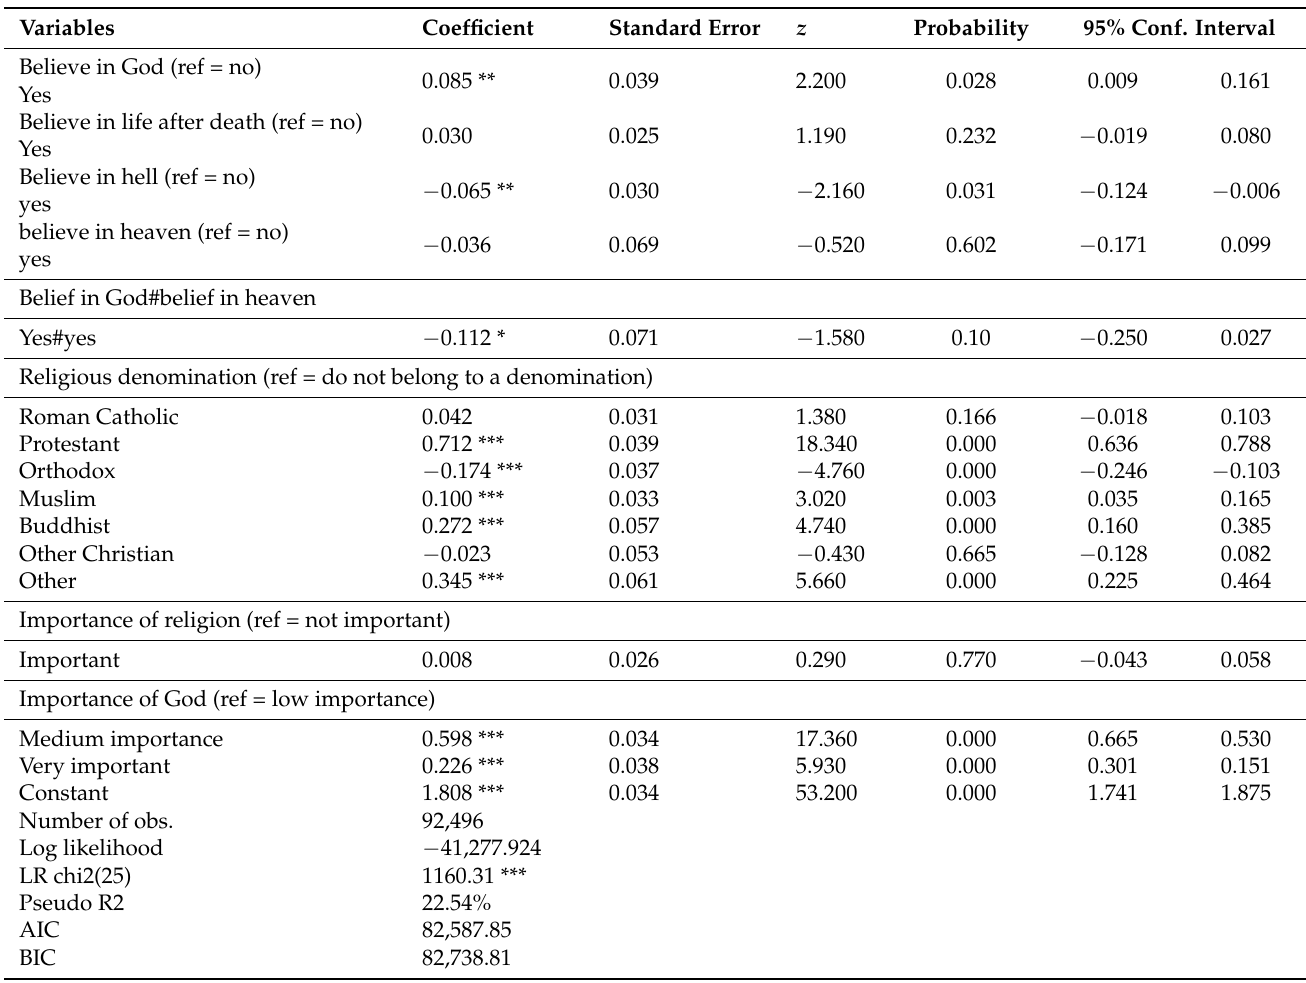
Table 4. The empirical results of tax morality logistic regression model with interaction effects based on chi-squared method of variable